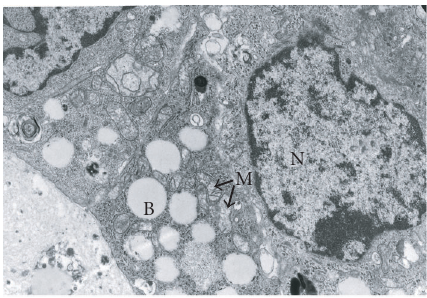
Figure 5. TEM micrograph of osteogenic cells producing bone nodules. B: bone nodules; M: mitochondria; N: nucleus.